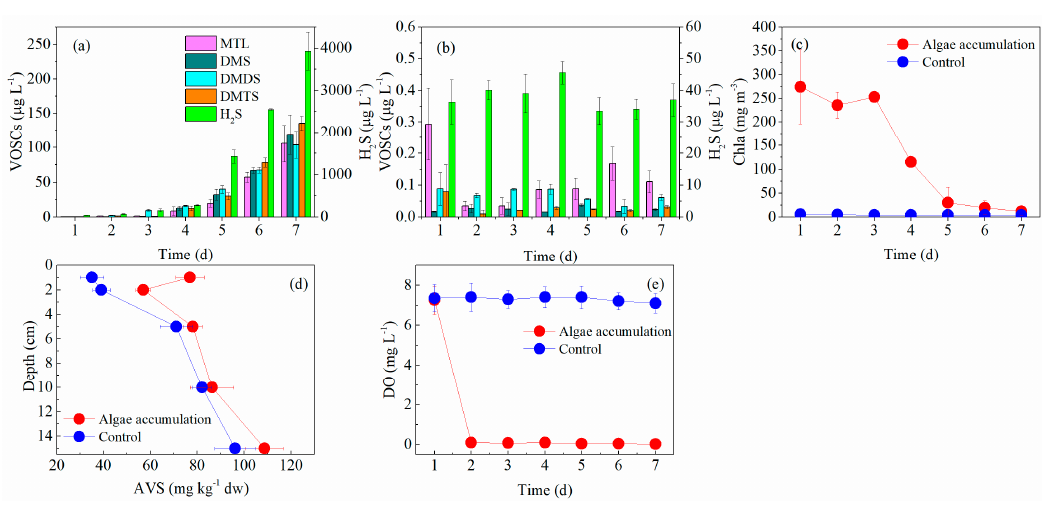
Figure 6. Development of the characteristics of the water-sediment system during the algae accumulation experiment: ( a ) Volatile sulfur compounds in the water during the algae accumulation; ( b ) volatile sulfur compounds in the control treatment; ( c ) the concentrations of chlorophyll a (Chl a ) in the water during the algae accumulation experiment; ( d ) profiles of acid volatile sulfide (AVS) at the end of the algae accumulation experiment; and ( e ) dissolved oxygen (DO) in the water during the algae accumulation experiment. Error bars indicate the standard deviation, n=3.